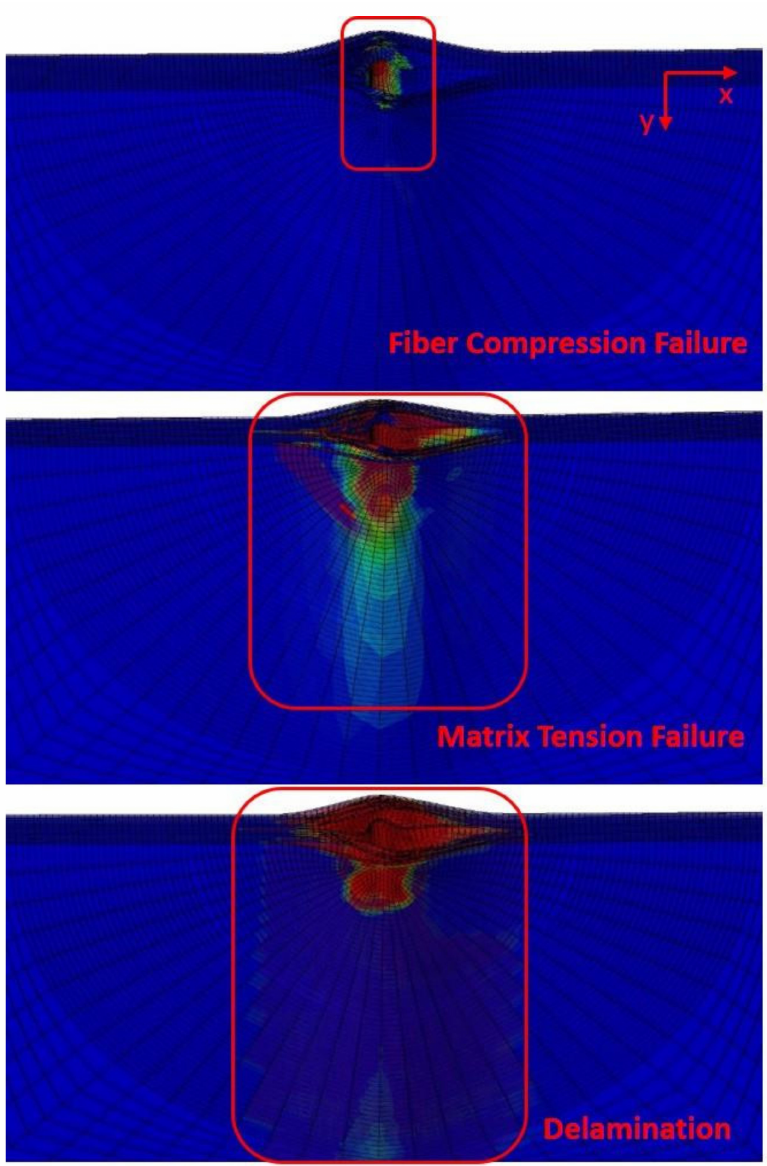
Figure 15. Damage scenario of CAEI of predicted